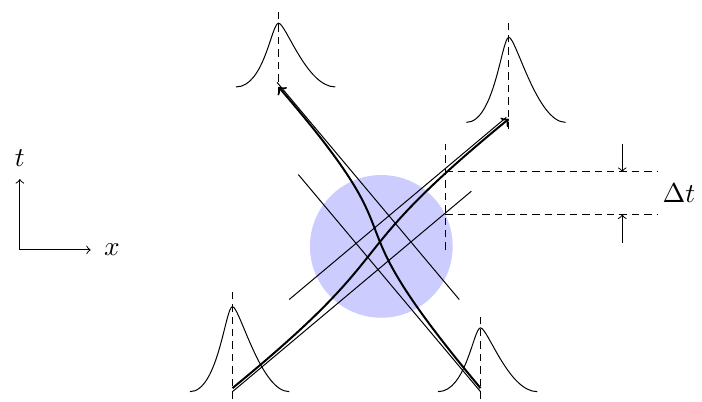
Figure 5 . The scattering of two giant magnons in space-time. The giant magnons scatter and retain their shape and velocities. The only e(cid:11)ect of the scattering is to introduce a time delay on the motion of the giant magnons as shown. Note that an attractive force between the giant magnons produces a time advance (cid:1) t < 0, whereas, here we have illustrated a repulsive force (cid:1) t >